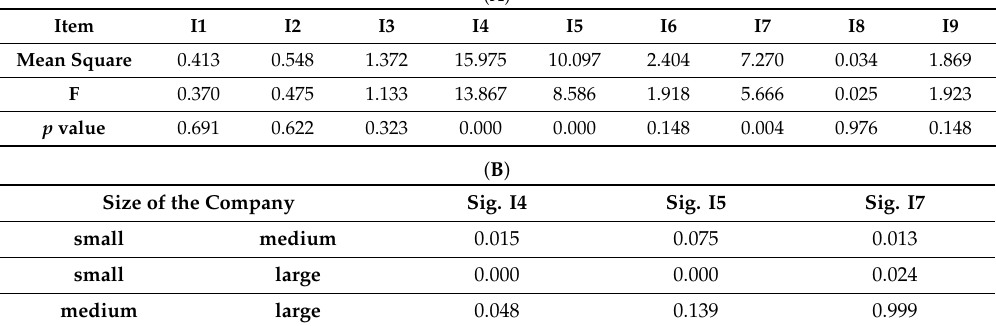
Table 6. ( A ) Significant di ff erences in HR strategy according to size of the company (ANOVA) and Post hoc tests for significant di ff erences in HR strategy (Tukey HSD). ( B ) Post hoc tests for significant di ff erences in HR strategy (Tukey